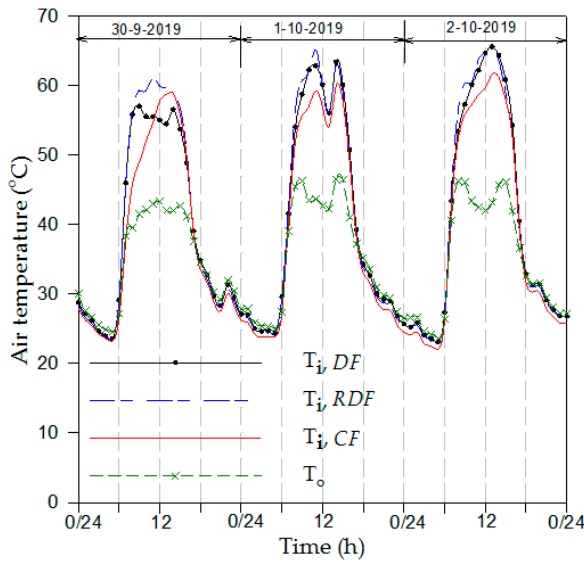
Figure 10. Time courses of the air temperature inside the greenhouse models covered with the DF , RDF , and CF films and outside the models.